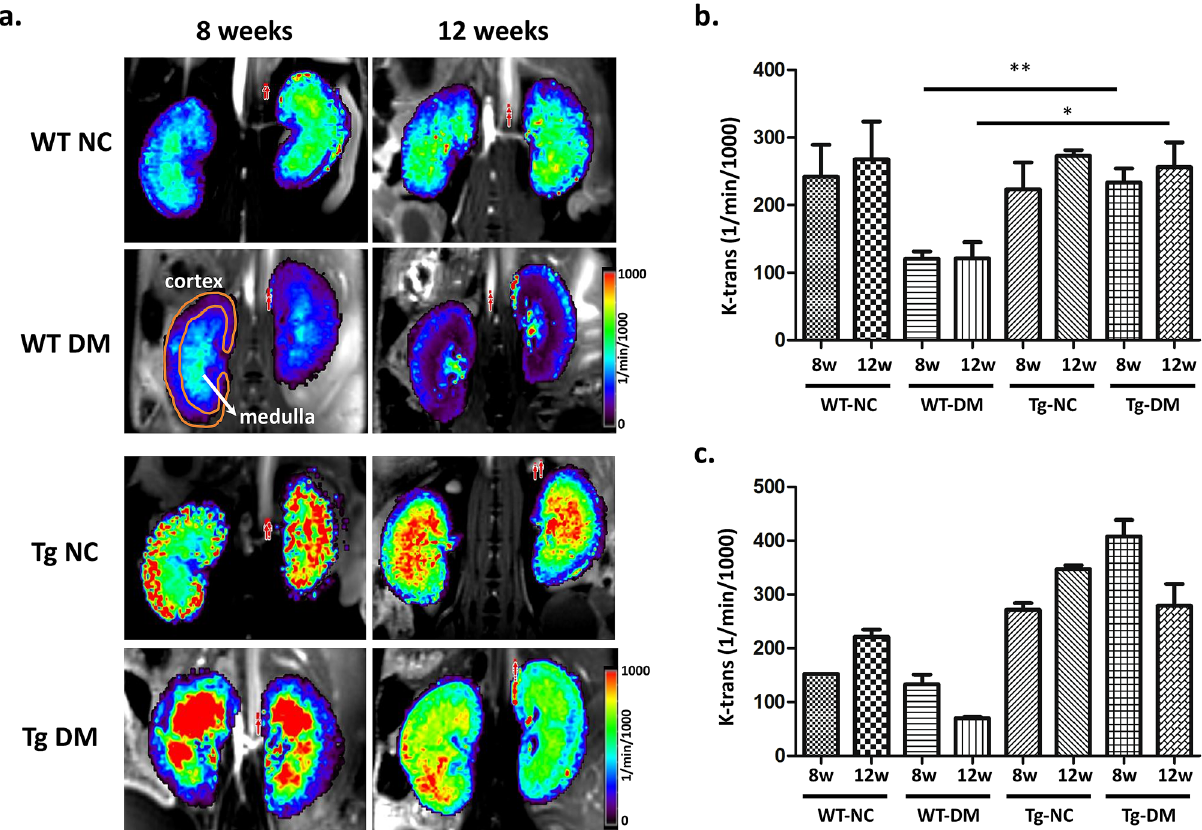
Figure 3. Comparison of DCE-MRI for wild-type and miR29a transgenic mice as the control and DM animals. (a) DCE-MR imaging with K trans mapping of kidneys in each experimental group from vascular-phase images, and the unit of the color bar is mL/min/1000 mL; (b) value of K trans in renal cortex structures with control and STZ induced DM groups; (c) value of K trans in renal medulla structures with control and STZ induced DM groups. (* < 0.05 with one-way ANOVA analysis, significant difference between each group; WT, wild-type; Tg, miR29a transgenic mice; NC, normal control; DM, diabetic mice; n =